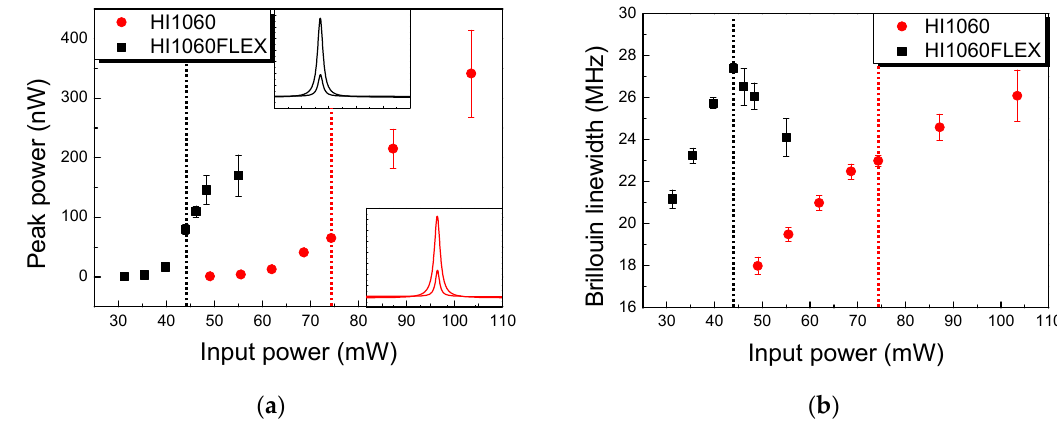
Figure 3. Variation of ( a ) SBS peak power and ( b ) linewidth Δν Β as a function of the input laser power at λ = 1064 nm in the room temperature for HI1060 and HI1060FLEX fiber with the length of 500 m. The SBS peak power increased monotonically with an increasing input laser power at λ = 1064 nm in both fibers as shown in Figure 3a. Note that in both cases, ν B did not change within the experimental error as indicated in the inset graphs of Figure 3a. The linewidth ∆ ν B showed a linear monotonic increase in HI1060, whereas in HI1060Flex ∆ ν B showed a maximum and decreased as the input laser power increased as i n Figure 3b. We noted the correlation between the peak SBS power and Δν Β is notably high such that Δν Β significantly changed as in Figure 3b when the slope of SBS peak changed in Figure 3a. See the dotted vertical lines in Figure 3a–b. Detailed variations in SBS linewidth in the 1060 nm SMFs were quite different from those of SMFs in the O,C-band [14,36] which were attributed to the difference in the waveguide structure and material composition. for HI1060 and HI1060FLEX, respectively. As expected from the fiber specifications, the P th of HI1060FLEX was significantly lower than that of HI1060 due to the smaller effective modal area in HI1060FLEX.